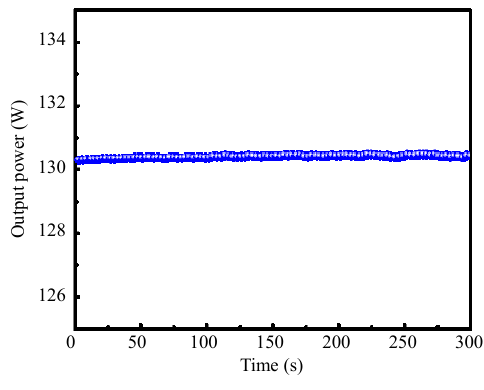
Fig. 5 Output power stability in a time scale of 300 s.